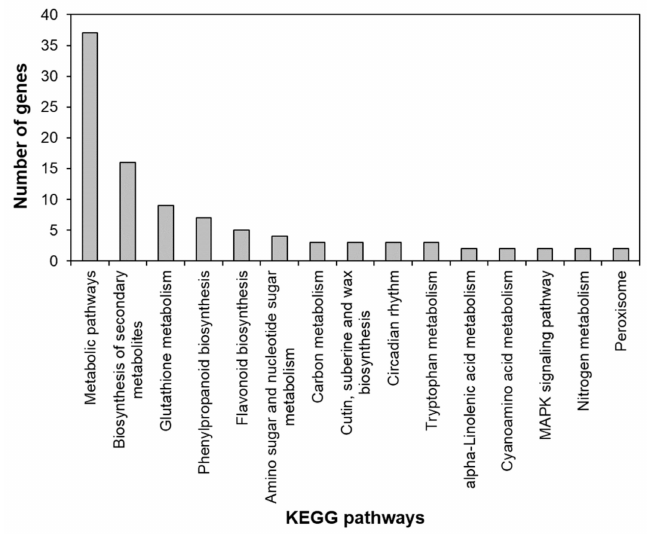
Figure 2. Kyoto Encyclopedia of Genes and Genomes (KEGG) pathway of upregulated genes in AtRH17 OXs. KEGG pathway was analyzed using KEGG Mapper.